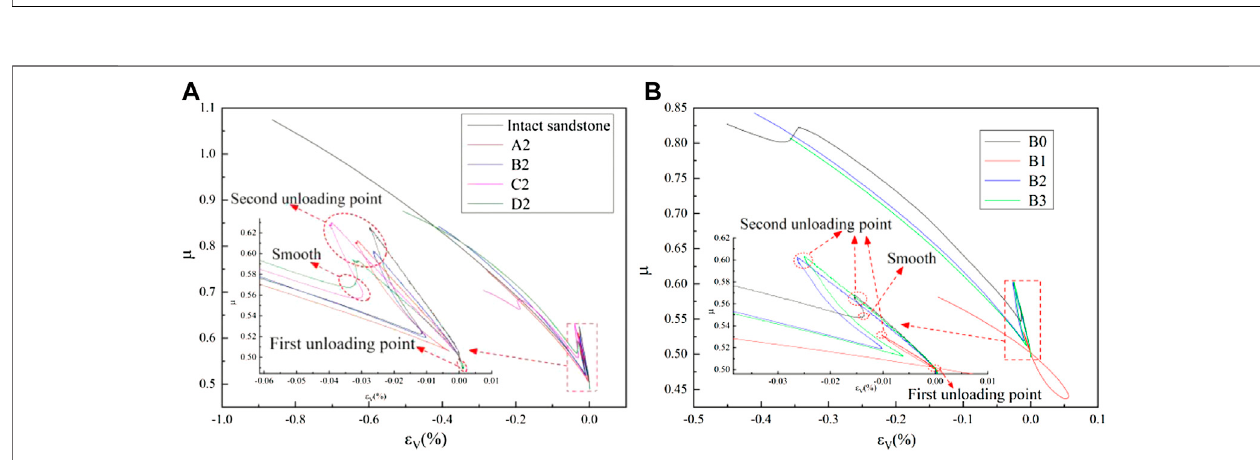
FIGURE 9 | Relationship between Poisson ’ s ratio and volumetric strain of the single-crack samples: (A) crack length (A2, 10 mm; B2, 15 mm; C2, 20 mm; D2, 25 mm); (B) crack angle (B0, 0 ° ; B1, 30 ° ; B2, 60 ° ; B3, 90 ° ).